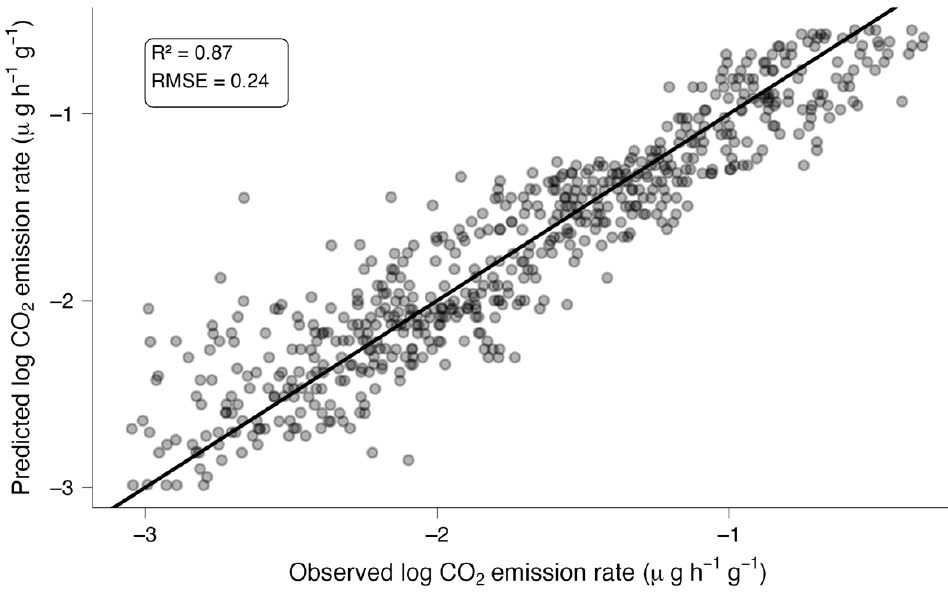
Figure 4. Relationship between observed and predicted CO 2 emission rates.